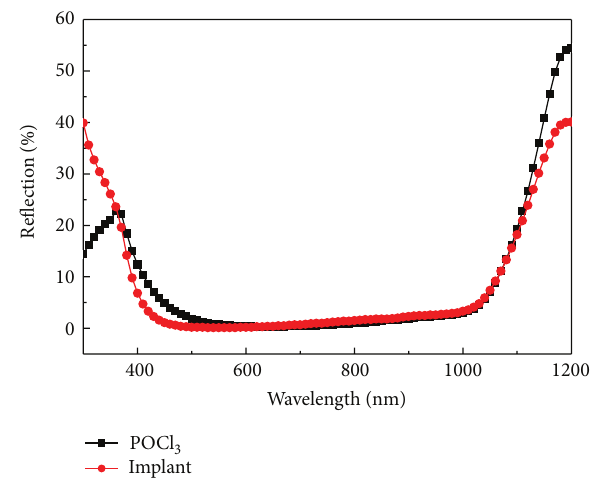
Figure 6: The average reflection for the POCl 3 diffusion and implantation process after SiN 𝑥